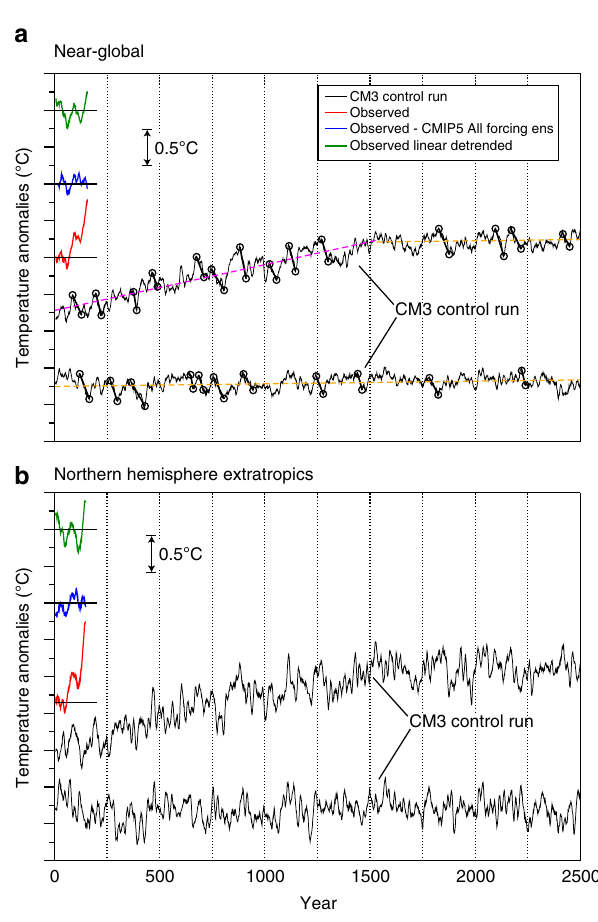
Figure 2 | Surface temperature anomalies from a 5200-year CM3 control run compared with observations. Anomalies ( (cid:2) C) averaged over ( a ) near global domain, 60 (cid:2) S-80 (cid:2) N or ( b ) northern hemisphere extratropics, 23.6 (cid:2) N-90 (cid:2) N. Ten-year running means are shown, with an arbitrary vertical shift for display purposes (see 0.5 (cid:2) C vertical scale; tic marks on vertical axis at 0.25 (cid:2) C intervals). CM3 control run 2m air temperature data (black lines) are averaged over the full domain noted, without screening out data where observations are missing. The red, blue and green lines on each plot depict HadCRUT4 observed combined SST/surface air temperature anomalies over available data regions for full observations (red), observed minus CMIP5 All-Forcing ensemble mean (blue) and observed minus linear trend (green). Open circles connected by straight line segments in a show the 25 CM3 control run multidecadal cooling events selected for further analysis in our study. The purple and orange dashed lines in a depict the two linear trends fit to separate sub- segments of the 5200 year CM3 control run (purple for years 1–1530 and orange for years 1,531–5,200), which were subtracted from the control run data to approximately filter out a spurious long-term drift signal. The upper black lines in a , b depict years 1–2500, and the lower black lines depict years 2501–5000 of the CM3 control run.